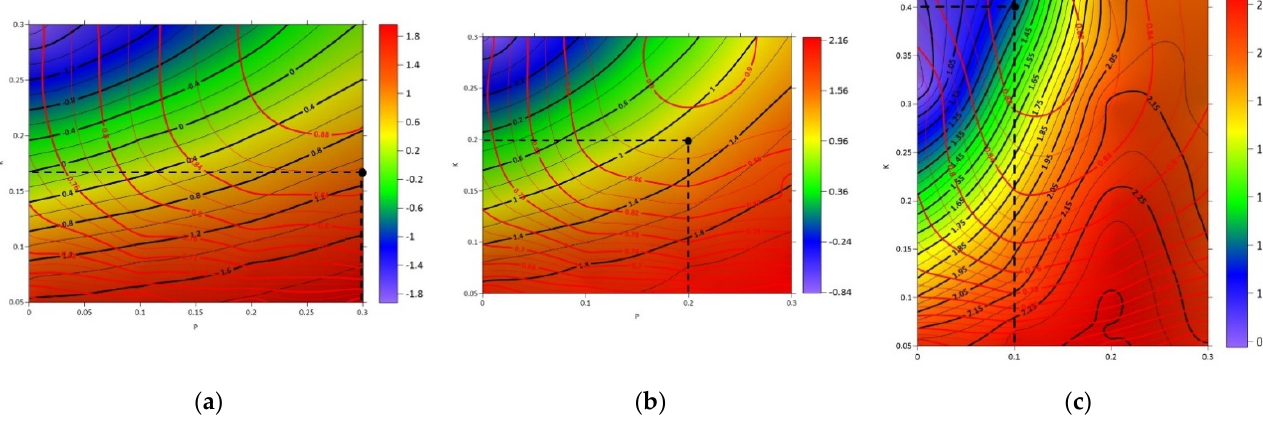
Figure 14. Comparison of difference between the arithmetic mean of measured and calculated LRR surface (black contour lines) and R 2 surface (red contour lines): ( a ) 0° N; ( b ) 9° N; ( c ) 20° N. The x -axis is the groin permeability P , while the y -axis is the GENESIS transport coefficient K . Black dashed lines indicate the K – P scenarios with the best performance (minimum R 2 , maximum RMSE ).